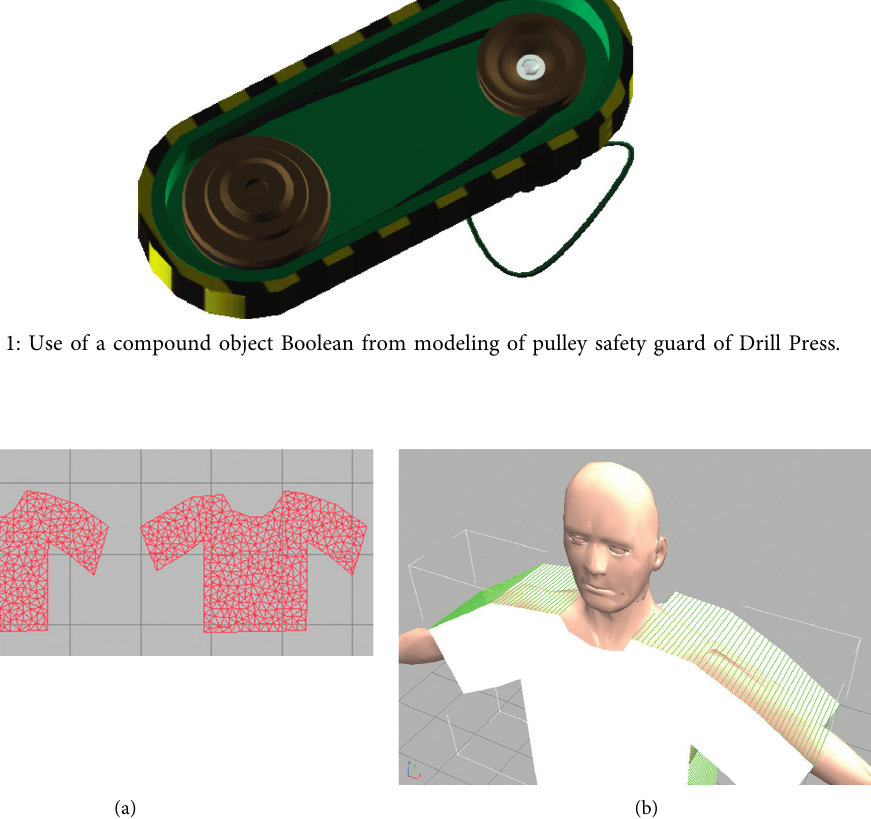
Figure 2: Elements of modifier Garment Maker help modeling of fabric. (a) Fabric mesh created using Dalaunaya algorithm; (b) connection of fabric edges by virtual